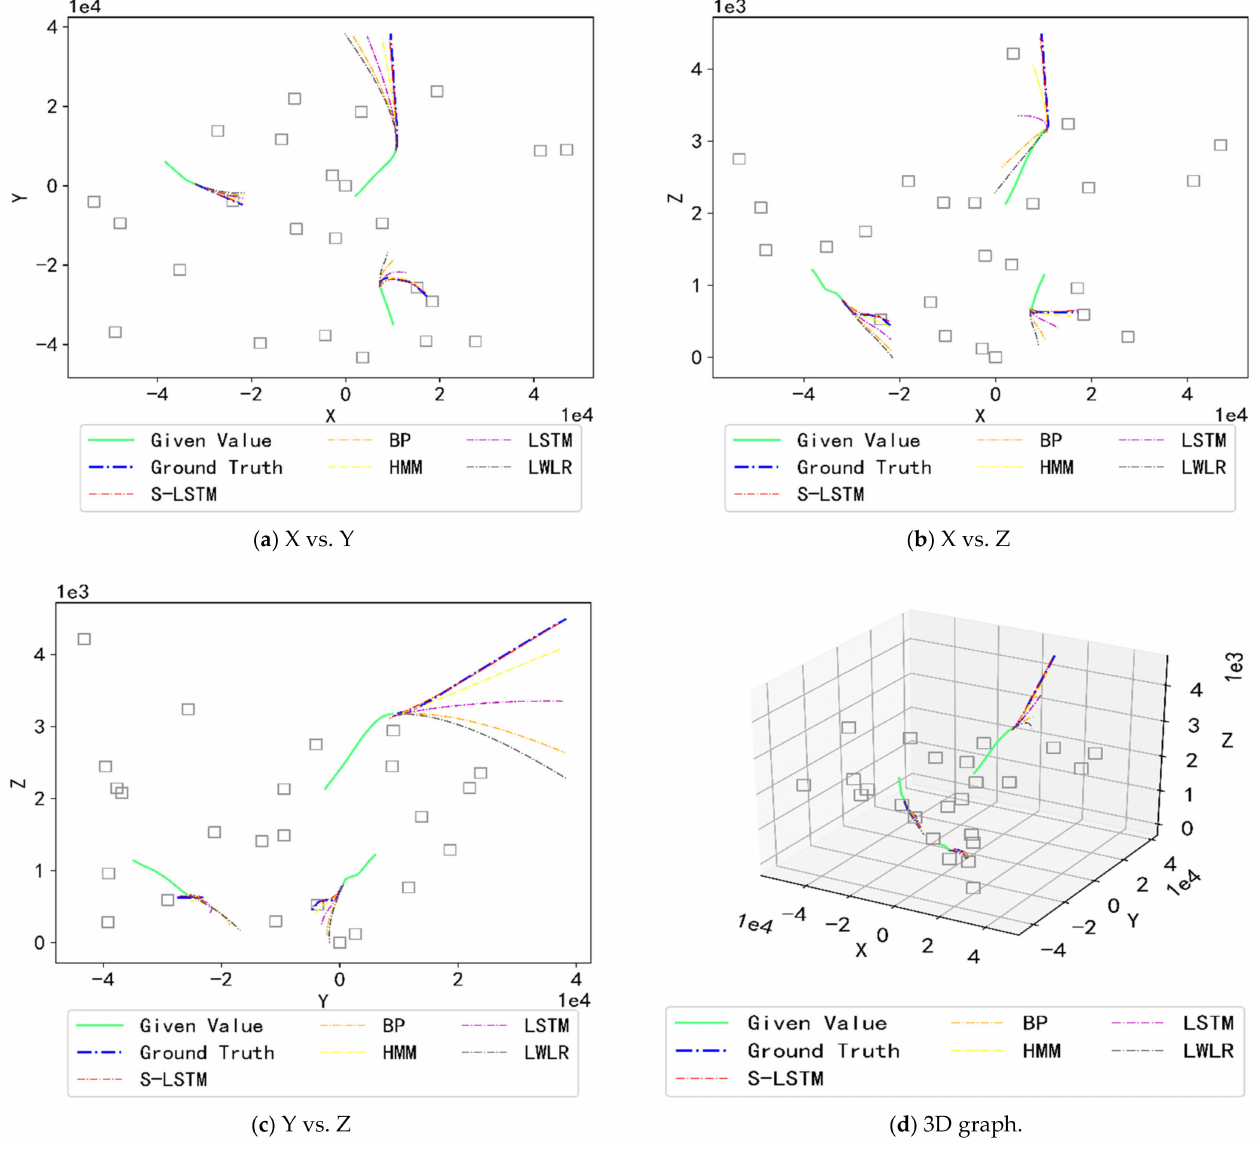
seven times. A gray triangle represents the representative aircraft in the figure, and the solid red line represents the actual trajectory of the corresponding aircraft. The blue dotted line represents the predicted value using S-LSTM, the orange dotted line represents the predicted value using LSTM, and other aircraft are represented by